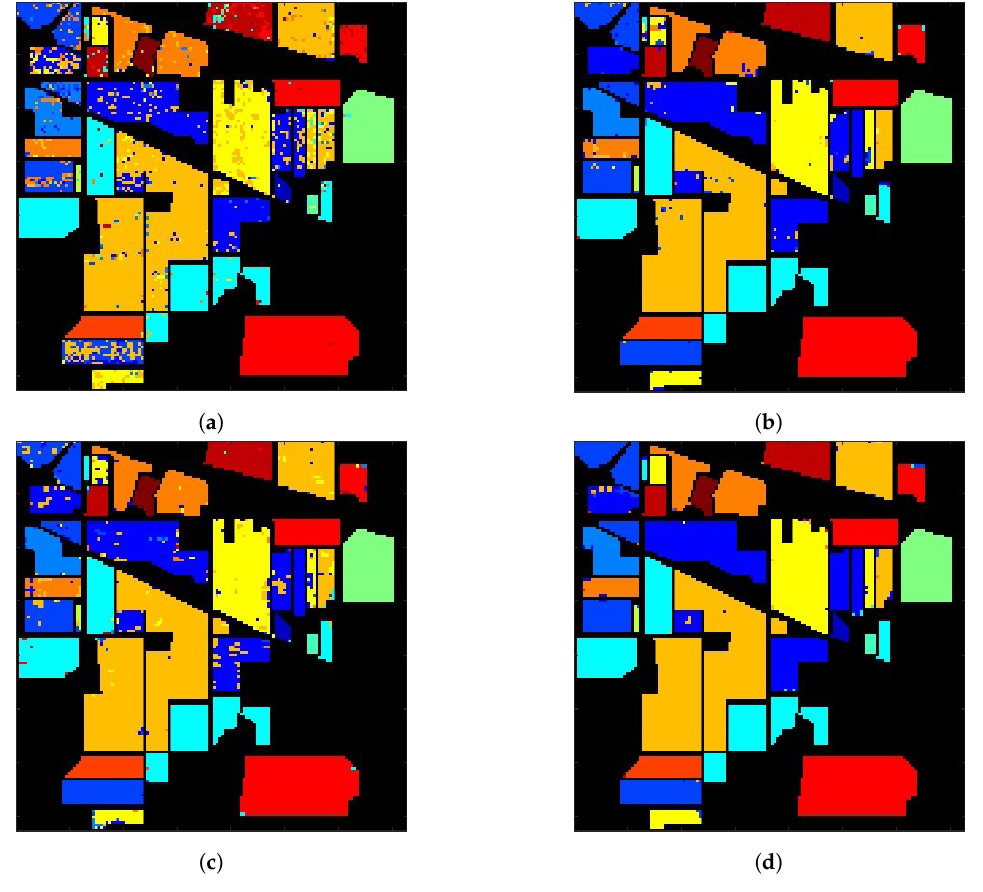
Figure 20. Classification images on Indian Pines HSI: ( a ) 1D-CNN with 200 bands, OA is 83.4%, ( b ) 1D-CNN with augmented input vectors of 641 (21 × 21 + 200) bands, OA is 95.4%, ( c ) 2D-CNN with input layer composed of one principal component from each pixel, OA is 91.5%, ( d ) 1D-CNN with augmented input vectors of 1964 ( ( 21 × 21 ) × 4 + 200) bands, OA is 98.1%, color code the same as in Figure 18.